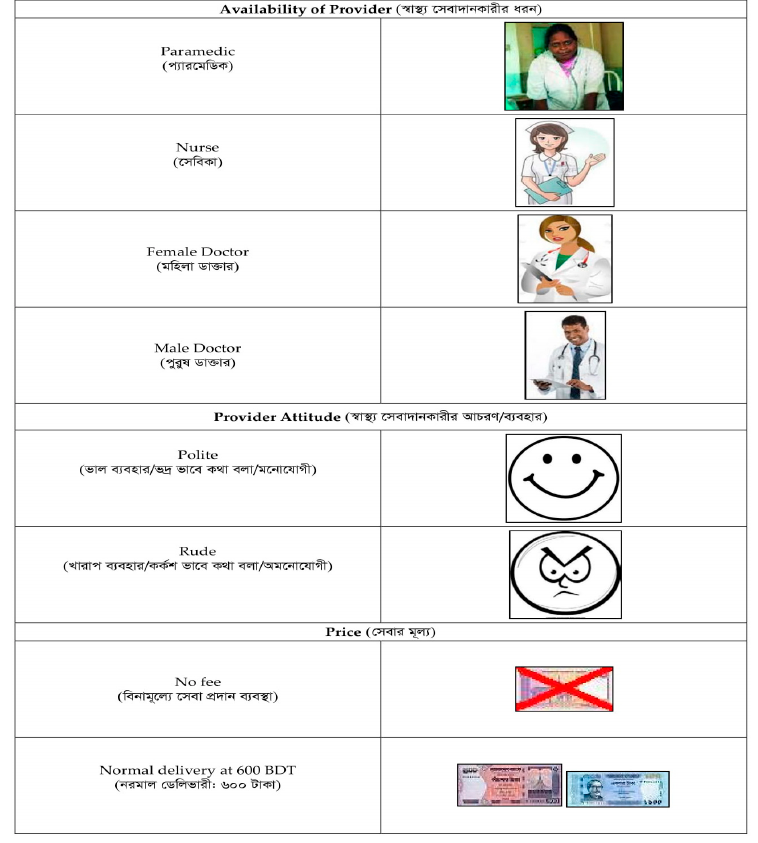
Table A1. A pictorial guideline of the study attribute and attribute levels. J. Clin. Med. 2019 , 8 ,